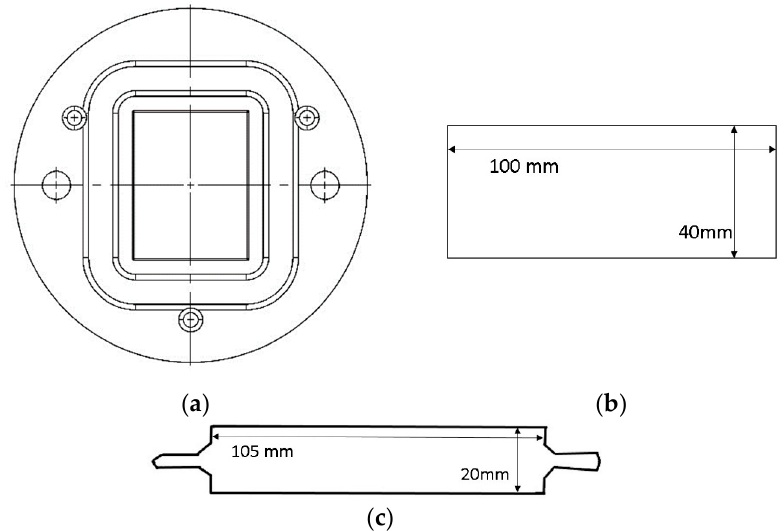
Figure 1. ( a ) Drawing of the closed die, ( b ) block sample before forging (50 mm × 100 mm × 40 mm), and ( c ) forged plate (82 mm × 105 mm × 20 mm).